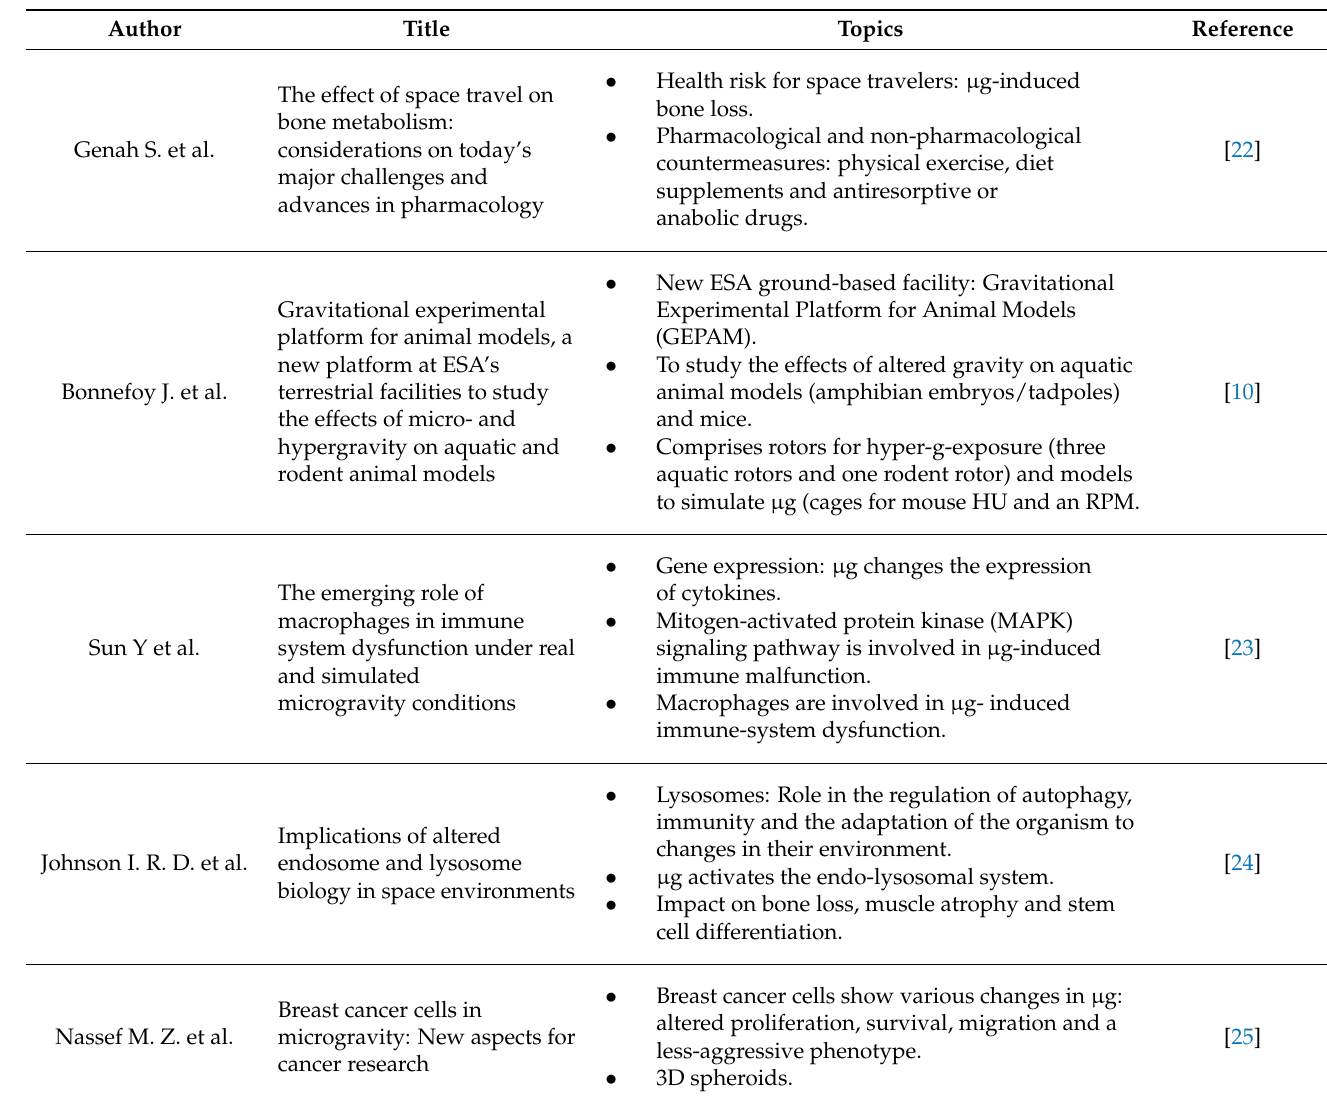
Table 2. Reviews contributed to the Special Issue “Microgravity and Space